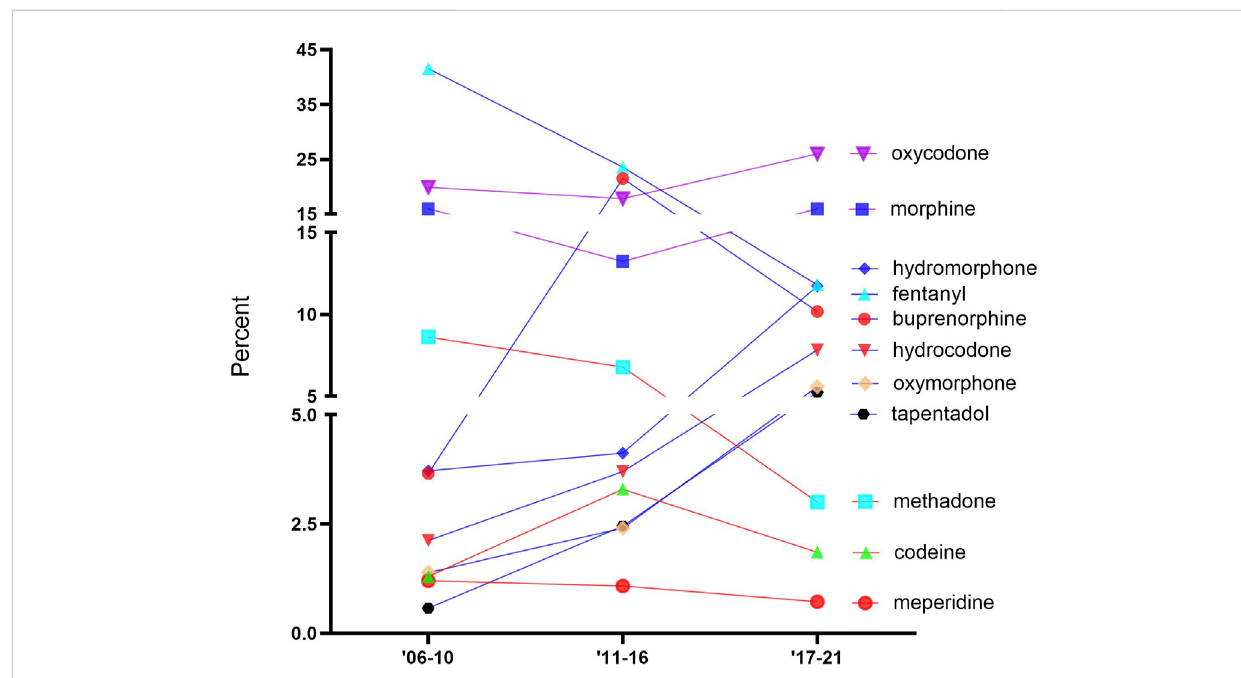
FIGURE 1 Percentage of adverse drugs events (ADEs) of the 11 prescription opioids obtained from the FDA Adverse Event Reporting System over